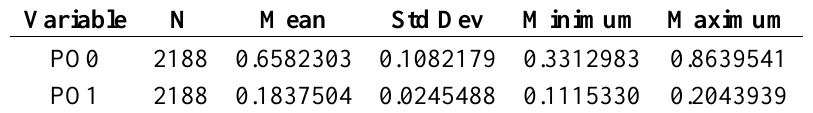
Table 5. Mean probabilities for the occurrence of zero and one accidents on 500 m segments.